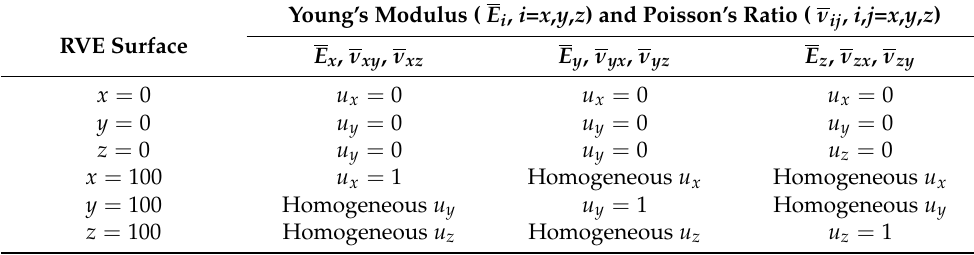
Table 3. RVE boundary conditions for the characterization of composite effective